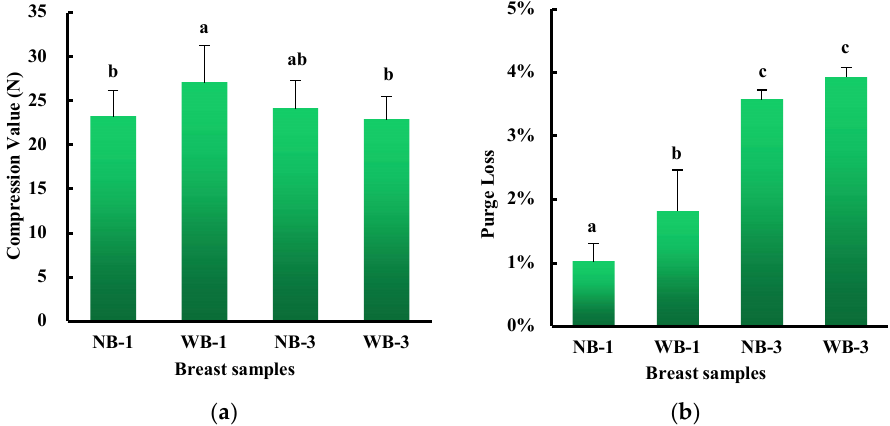
Figure 2. Compression value ( a ), purge loss ( b ) of wooden breast (WB) and normal breast (NB) muscles of broilers at day 1 and day 3 postmortem. Means without a common superscript (abc) differ; p < 0.05.